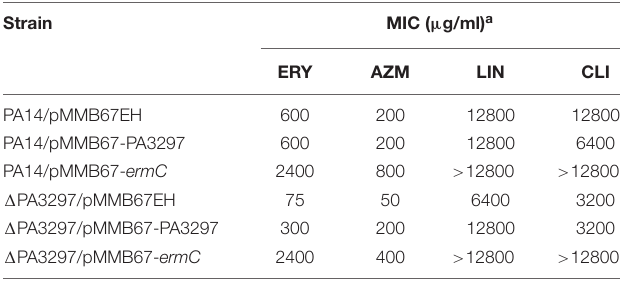
TABLE 4 | Bacterial susceptibilities to macrolides and lincosamides.